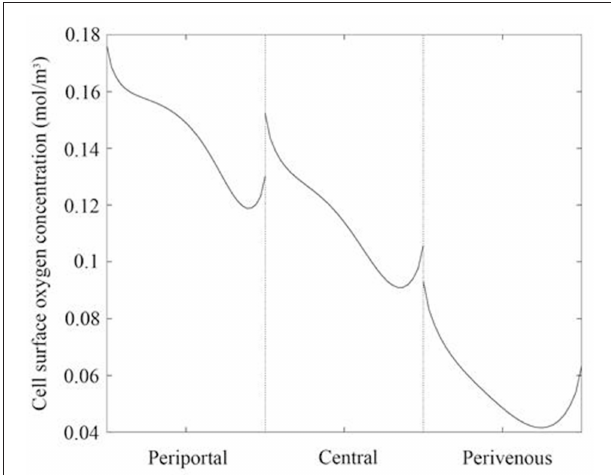
FIGURE 3 | Oxygen concentration profile across the center of the cell surface for each liver zone. Periportal (cells raised by 7mm), central (cells raised by 4mm), and perivenous (cells raised by 0mm i.e., cultured at the base of the chamber).